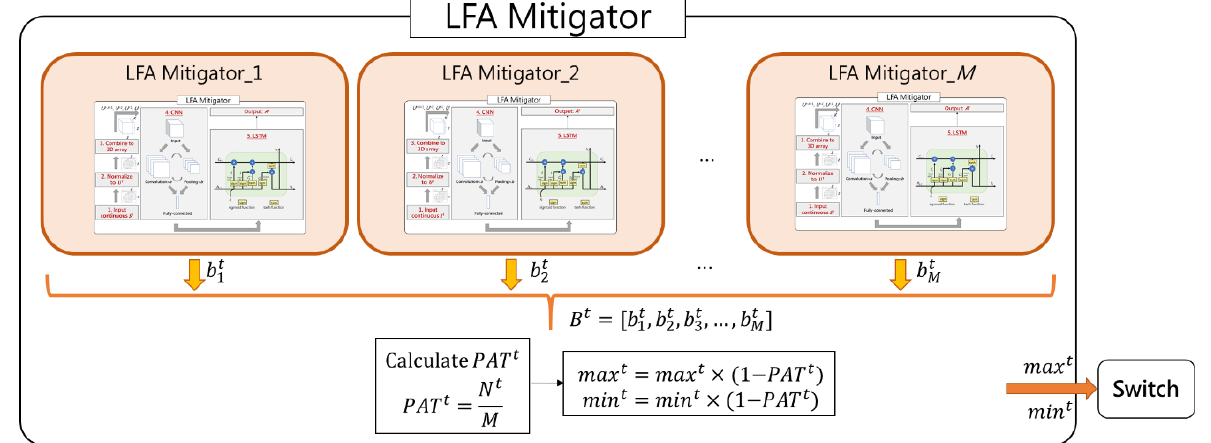
Figure 7. Architecture of LFA Mitigator module.